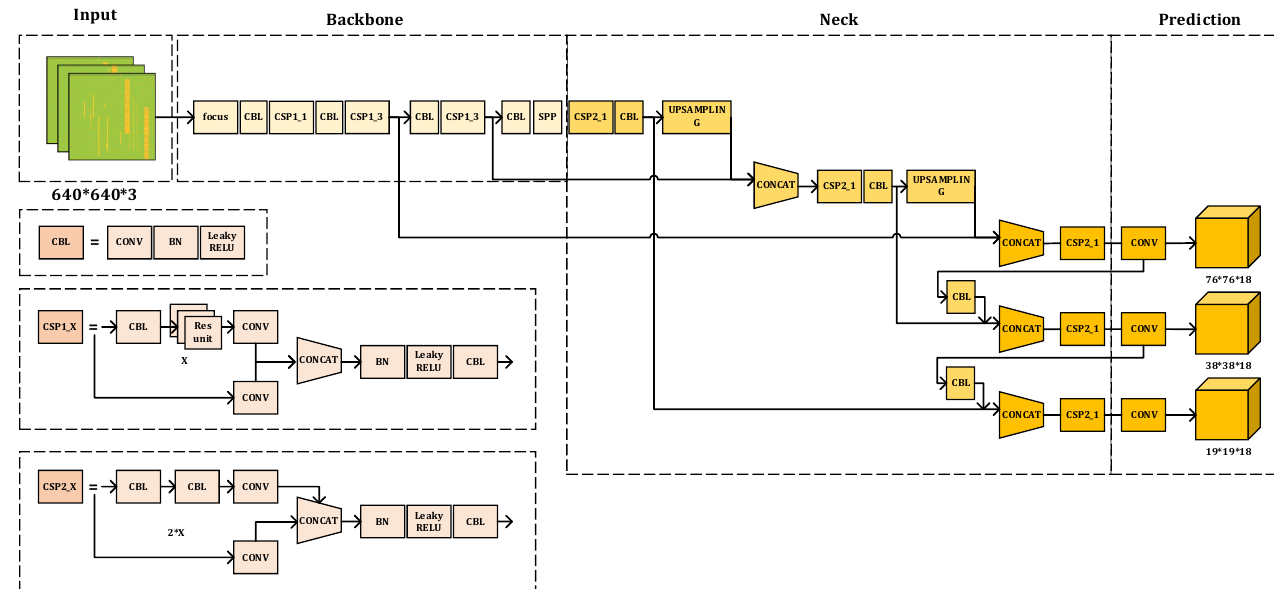
Figure 5. YOLOv5 network structure diagram.